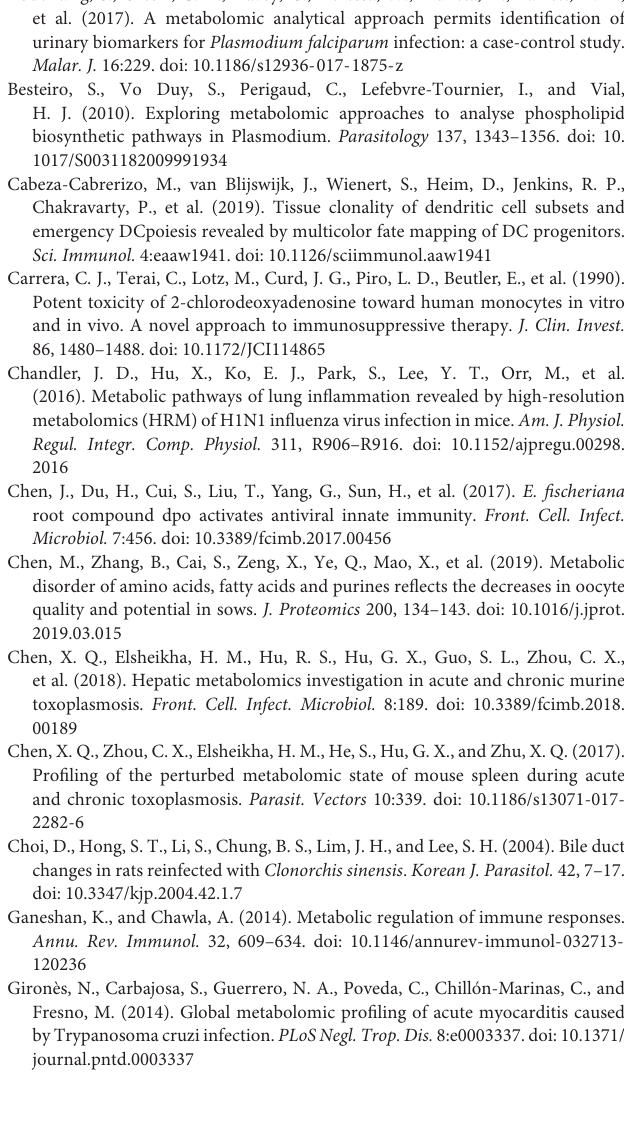
Supplementary Figure S7 | The pathway analysis during C. sinensis infection in ESI − mode. Plots depict the pathway impacts of the key metabolites ( x -axis) and the computed metabolic pathway as a function of − log (P) ( y -axis) that different between the 4 wpi vs control (A) , 8 wpi vs control (B) , 8 vs 4 wpi (C) . Supplementary Table S1 | Parameters of PCA and OPLS-DA models based on the date from sub-comparisons in the positive ion mode (ESI + ) and the negative ion mode (ESI − ). Supplementary Table S2 | List of metabolites identified in the entire infection